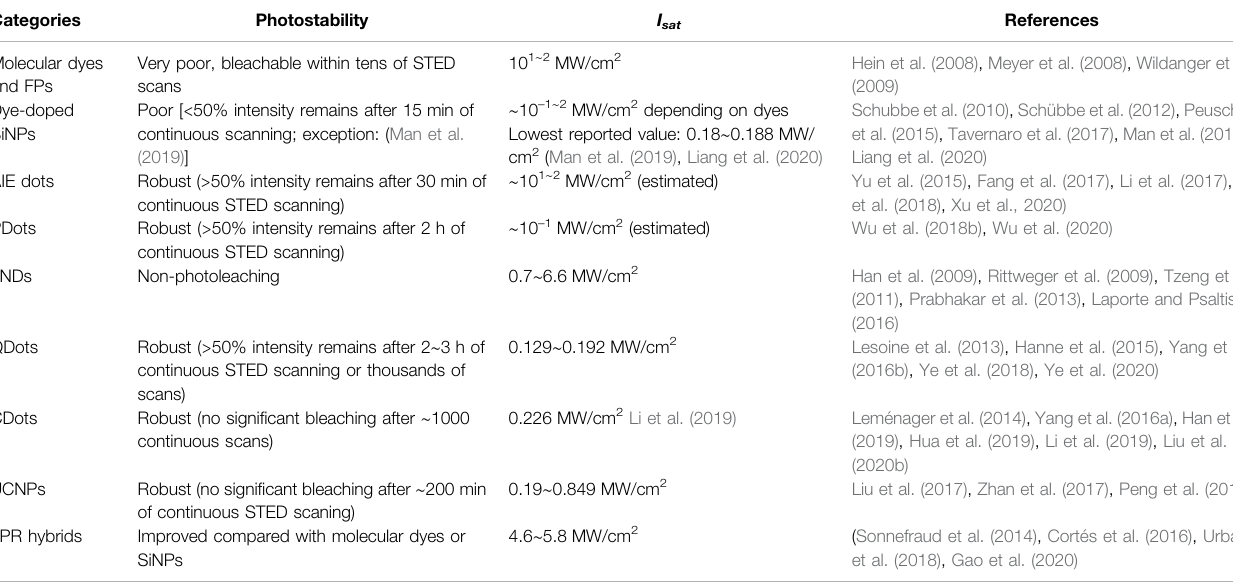
TABLE 2 | Summary of photostability and saturation intensities for STED